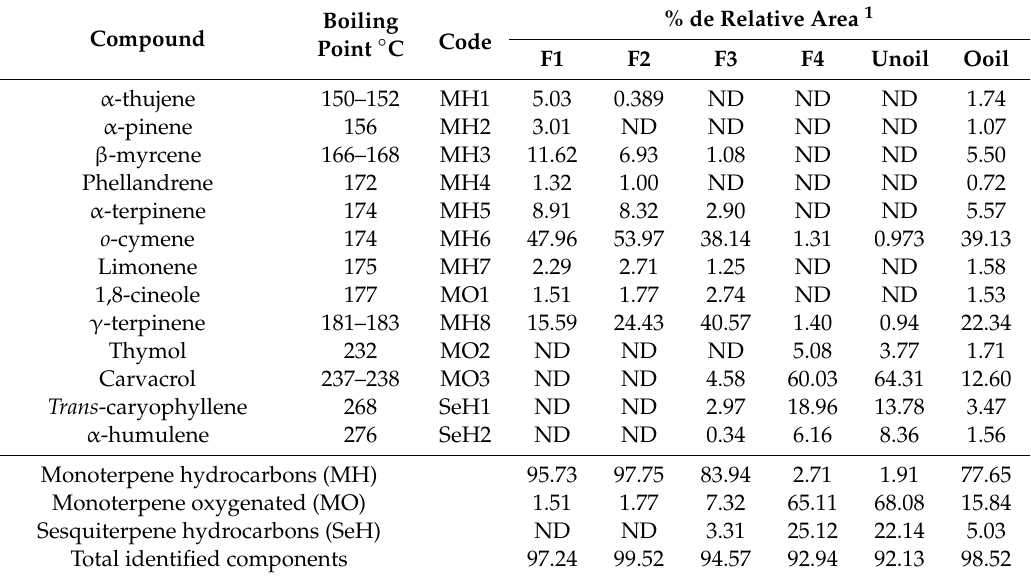
Table 2. Profile of the organic compounds found in the fractions